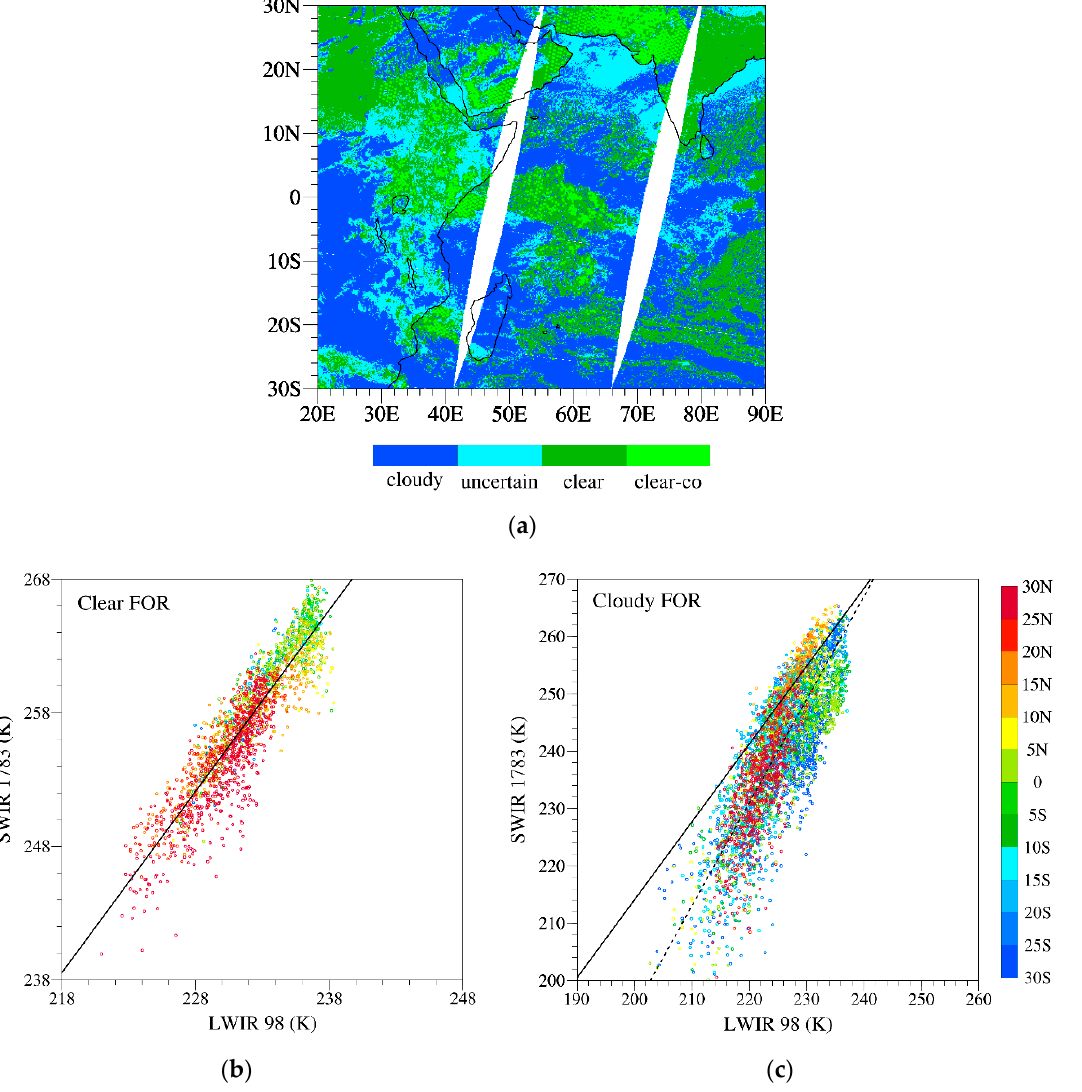
Figure 9. Distribution of the ( a ) MOD035 cloud mask at a 5-km resolution at descending node on January 1. Bright green dots are collocated HIRAS clear-sky observations. Scatter plots of HIRAS brightness temperature of LWIR 98 and SWIR 1783 are from ( b ) clear-sky and ( c ) cloudy observations in this area. Black lines indicate the linear regression between LWIR and SWIR brightness temperature under clear-sky condition (solid) and cloudy condition (dashed).